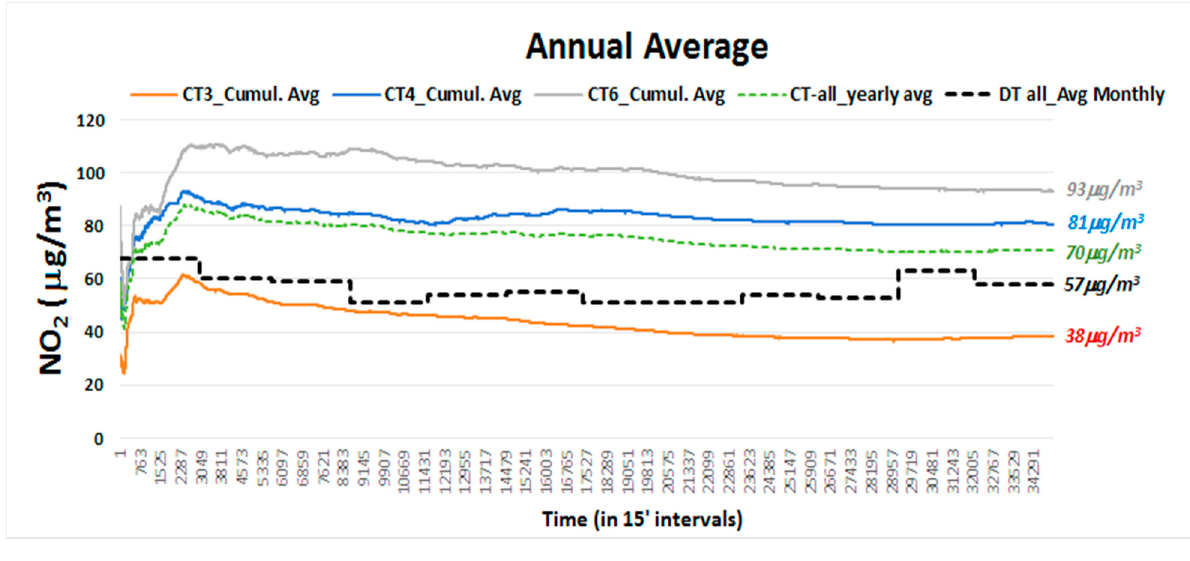
Figure 5. Cumulative average NO 2 concentrations (µg/m 3 ) at CoL CMS and Diffusion Tube Sites (2017 Calendar Year).